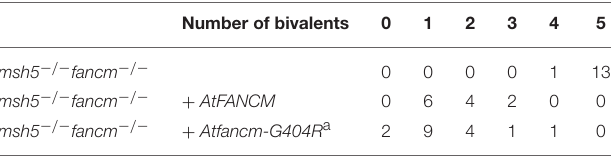
TABLE 2 | Chromosome segregation in A. thaliana msh5 fancm double-mutant transformed with different version of FANCM . Number of bivalents 0 1 2 3 4